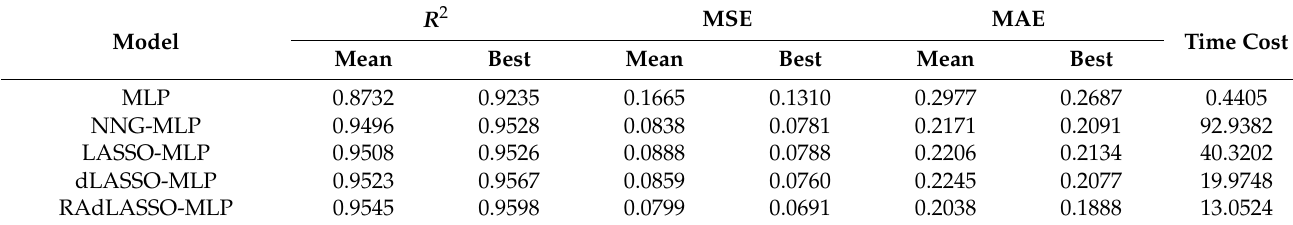
Table 3. Comparison results of different algorithms for normal data ( X 2 ∈ R n × 90